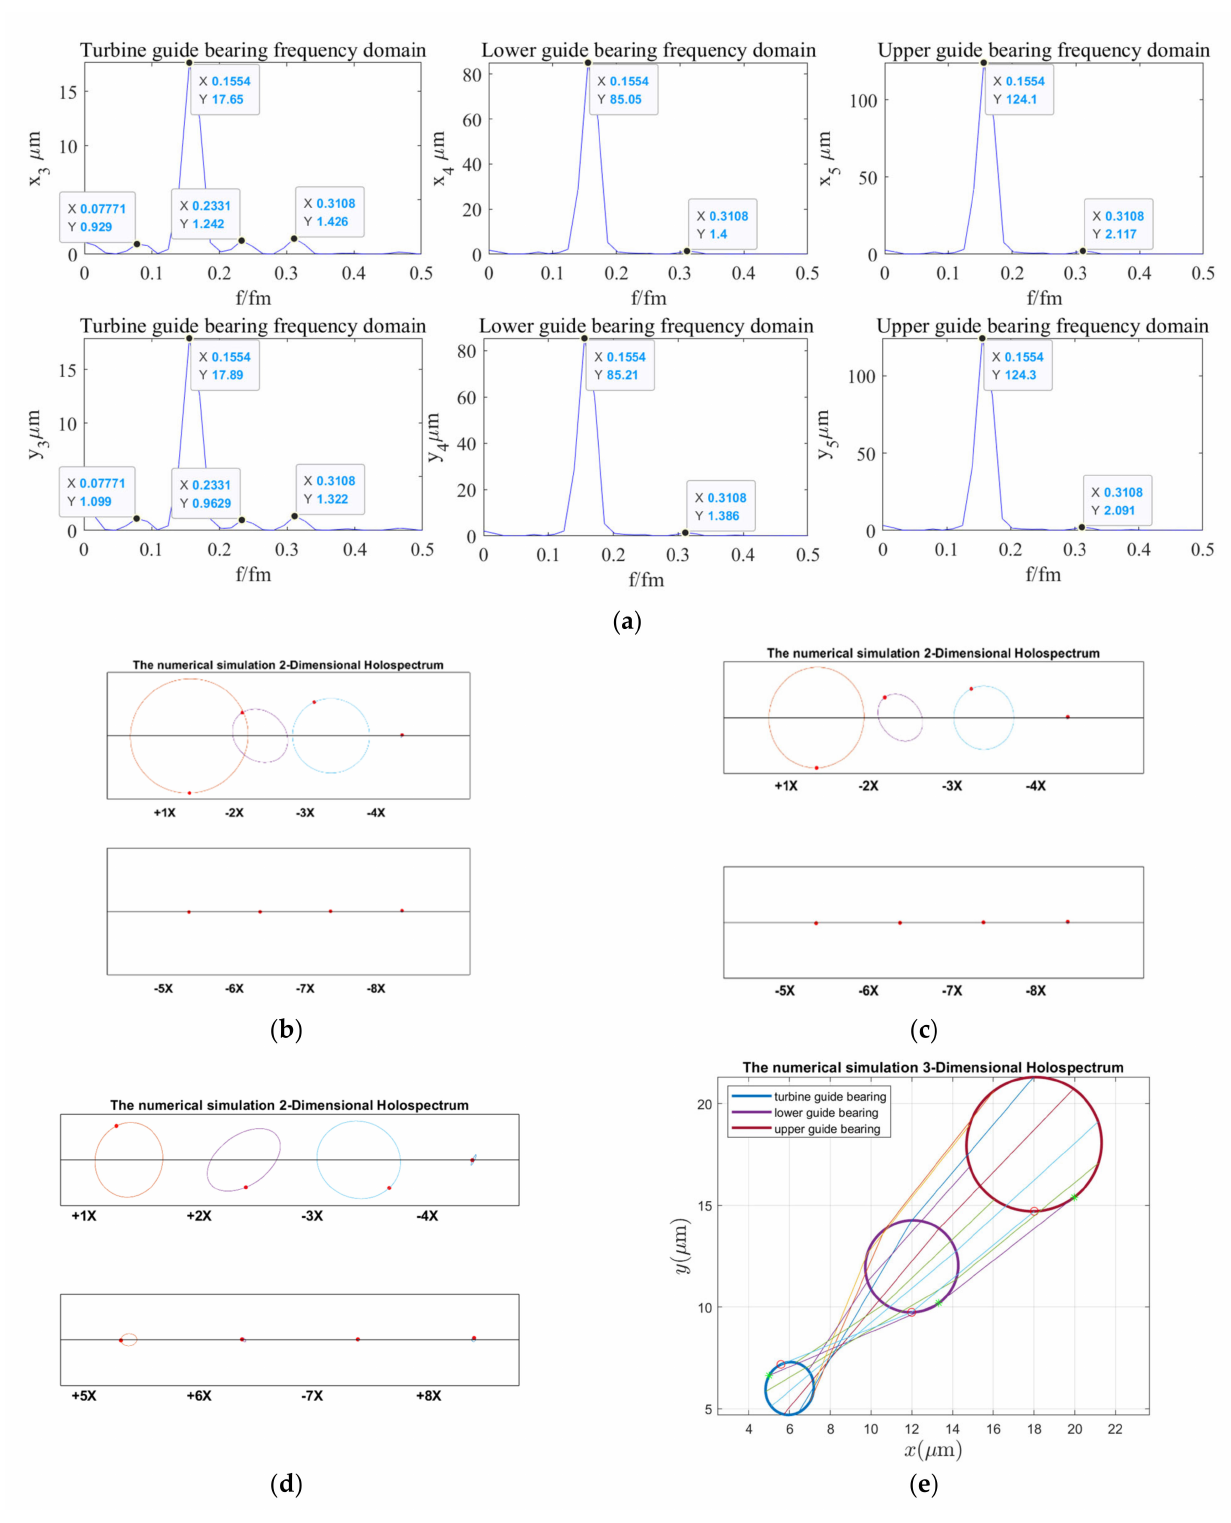
Figure 20. Shafting vibration holospectra of multi-vibration sources: ( a ) Shafting vibration spec- trogram, ( b ) Upper guide bearing 2D holospectrum, ( c ) Lower guide bearing 2D holospectrum, ( d ) Hydro-turbine guide bearing 2D holospectrum, ( e ) One-fold frequency 3D